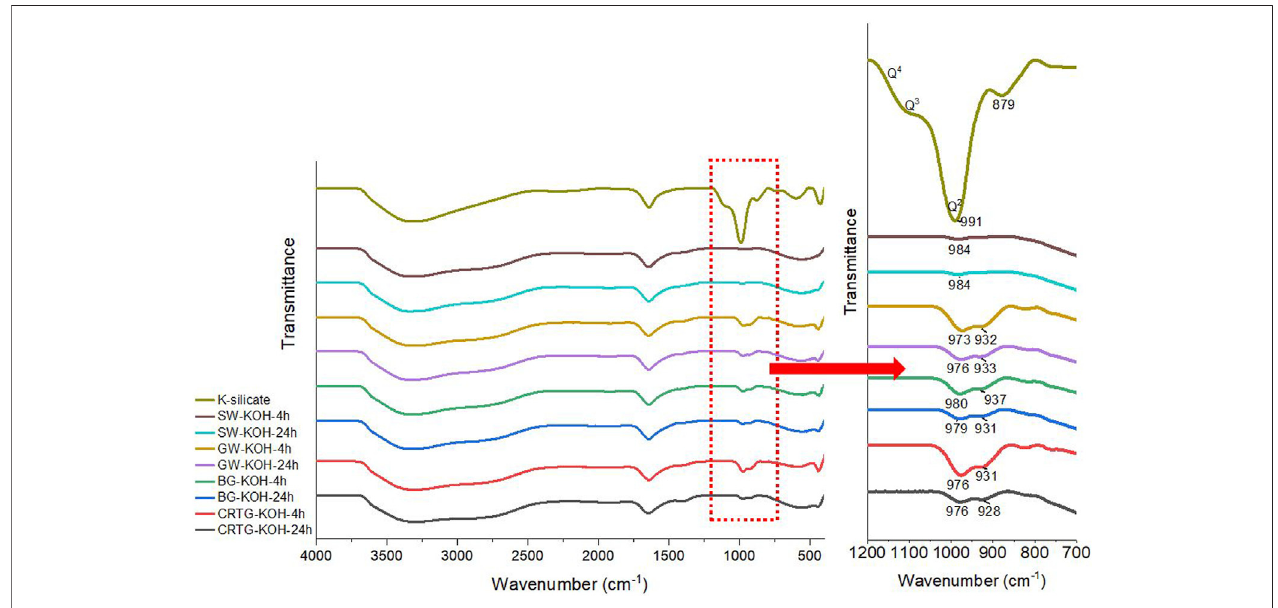
FIGURE 1 | FTIR spectra of the alternative activators based on 10 M KOH.